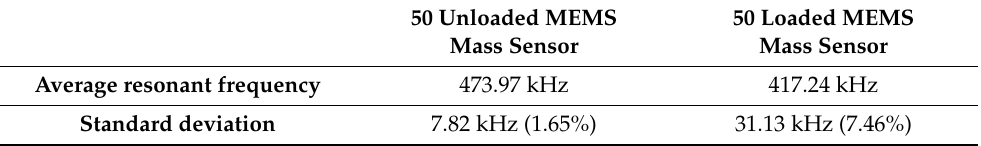
Table 5. Statistics of the mechanical resonance measurement of the mass sensor